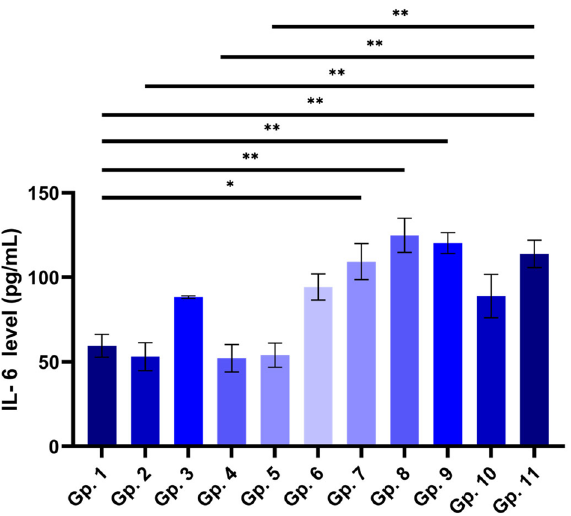
Figure 8. Effect of BV, irradiated BV, CS-NPs, and BV-loaded CS-NPs on IL-6 level in studied groups. Gp.1: Mice injected with PBS as a control group, Gp.2: Mice injected with BV, Gp.3: Mice injected with irradiated BV, Gp.4: Mice injected with CS-NPs, Gp.5: Mice injected with BV- loaded CS-NPs, Gp.6: Infected mice with S. aureus, Gp.7: Infected mice treated with BV, Gp.8: Infected mice treated with irradiated BV, Gp.9: Infected mice treated with CS-NPs, Gp.10: Infected mice treated with BV–loaded CS-NPs, Gp.11: Infected mice treated with an antibiotic. Data were analyzed using one-way ANOVA and represented as Mean ± Standard Error of mean (SEM). (*) is considered significant P < 0.05, (**) is considered highly significant P <